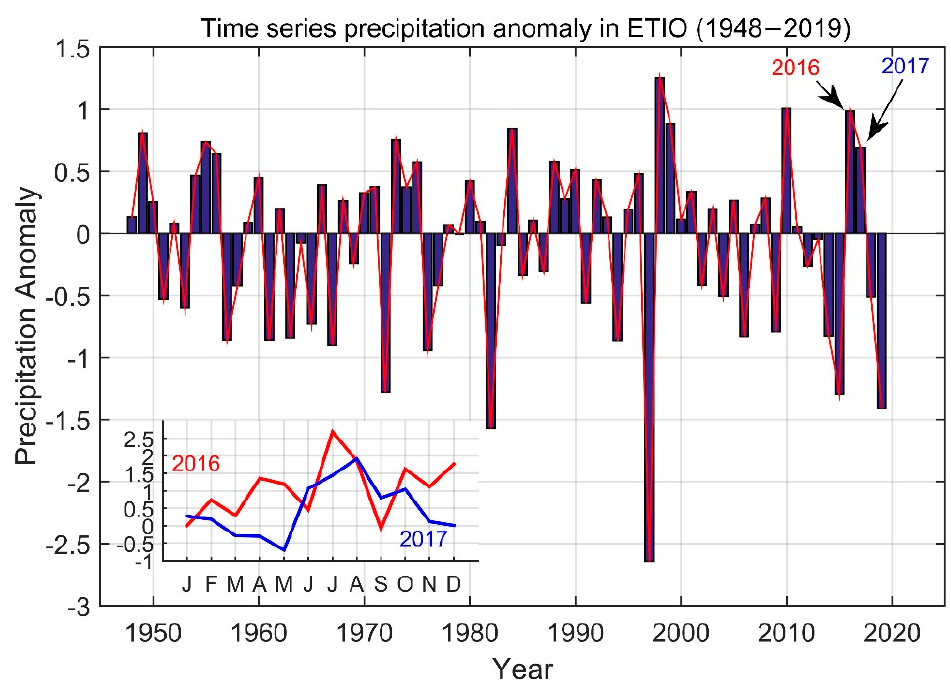
Figure 11. Time series (1948–2019) of precipitation anomalies in the ETIO region. Datasets provided by NOAA precipitation reconstruction (PREC). The climatology is based on a time period covering 1979–1998. The monthly distribution of precipitation anomalies in 2016 and 2017 is shown within the figure.